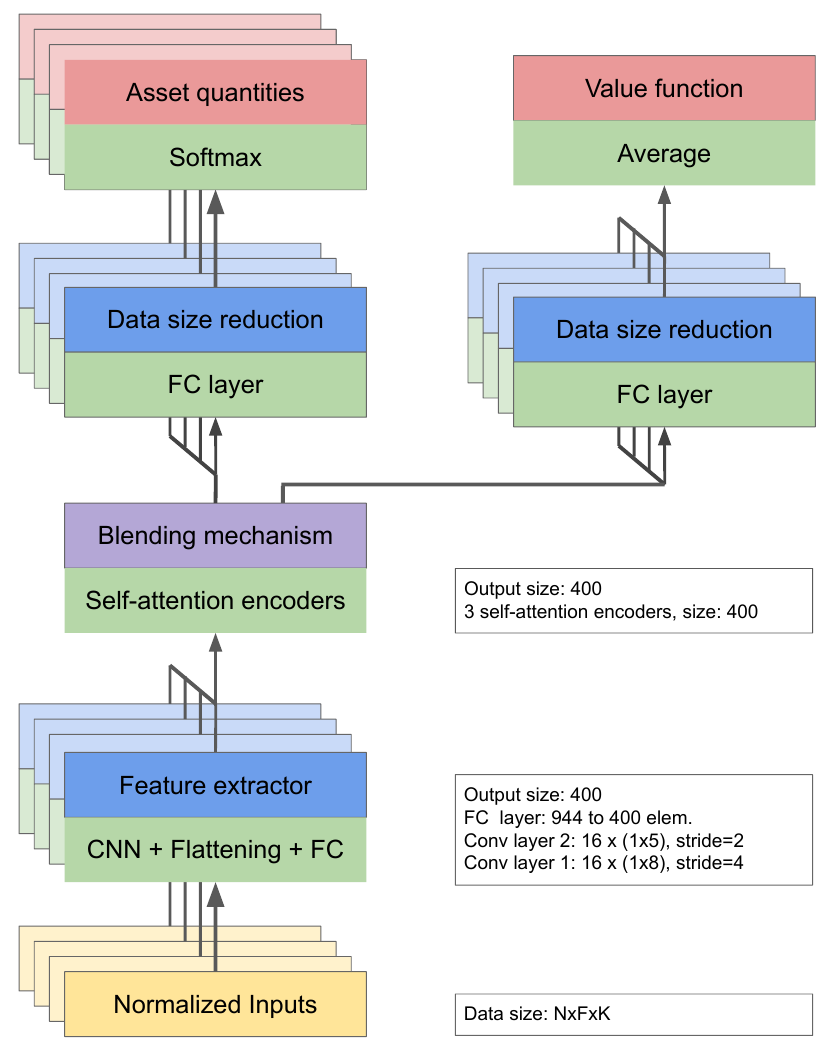
Figure 5. Self-attention network diagram for cryptocurrency trading. The activation function of all FC layers is the ReLU function. The output size of the final FC layers is